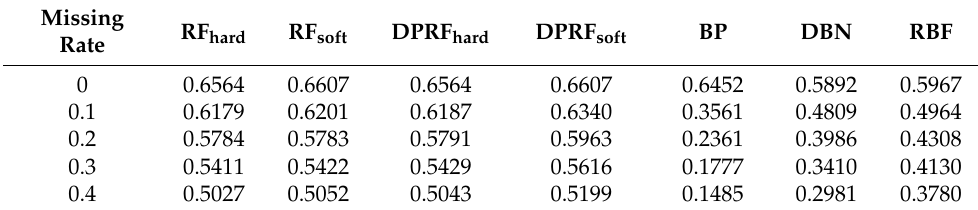
Figure 4. Comparison of OACC values at different missing rates. Table 3. OACC values of the seven FDD